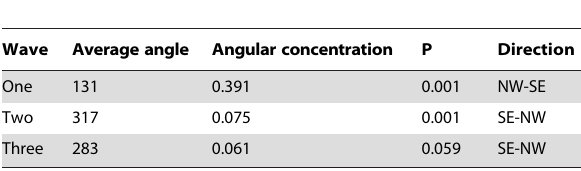
Table 2. Results of directional statistics for three different waves of HPAI-H5N1 outbreaks in Bangladesh,